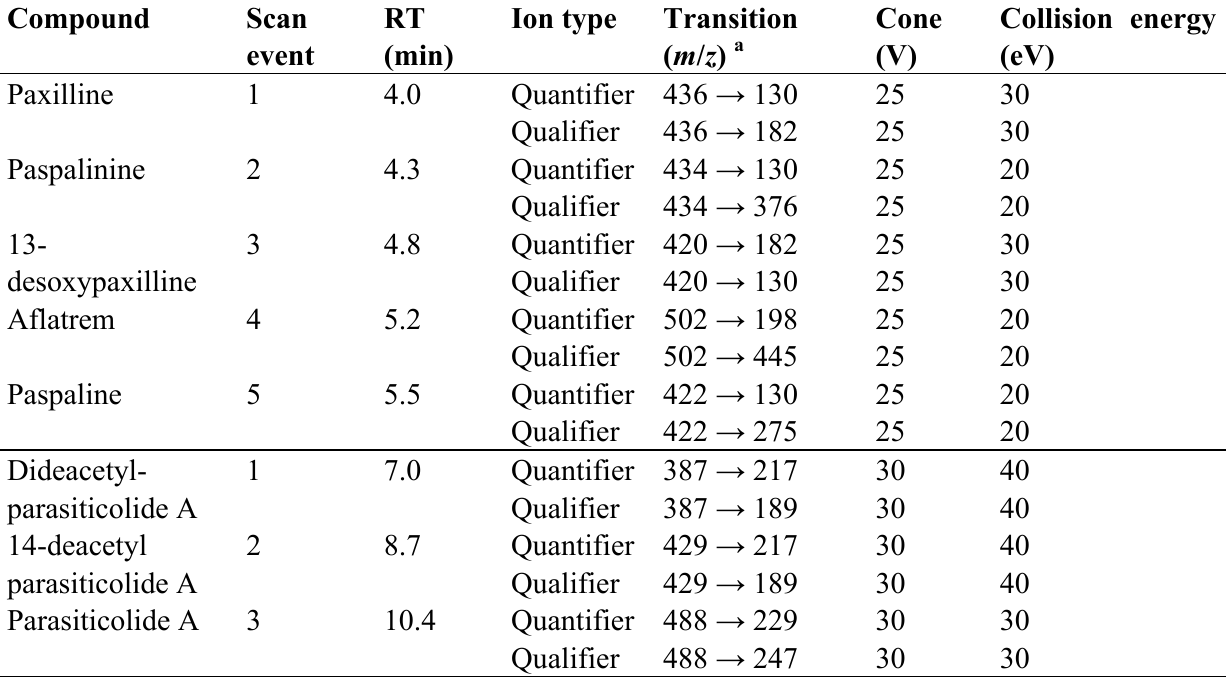
Table 2. MS/MS method including scan event, retention times, transition ions and the cone and collision energies